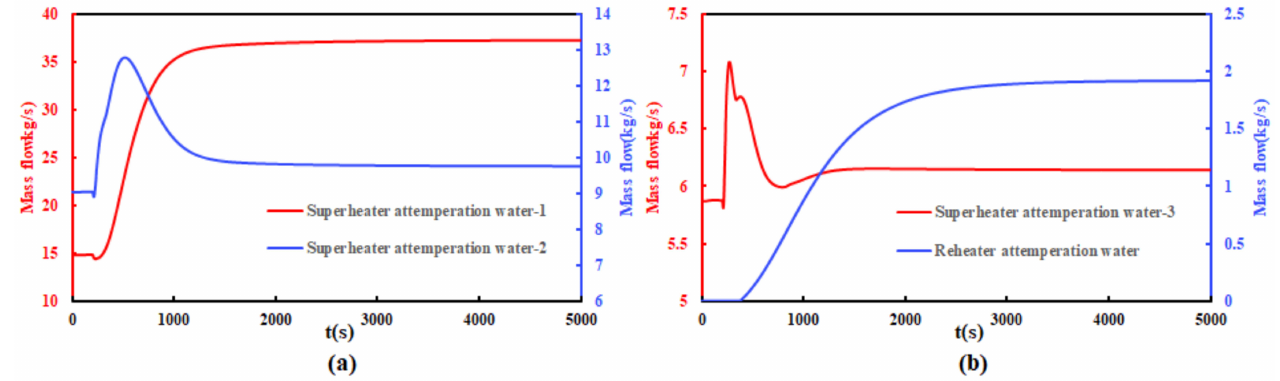
Figure 12. Attemperation water system response when feedwater mass flow decreased by 5%: ( a ) superheater attemperation water-1 and superheater attemperation water-2 mass flow; ( b ) superheater attemperation water-3 and reheater attemperation water mass